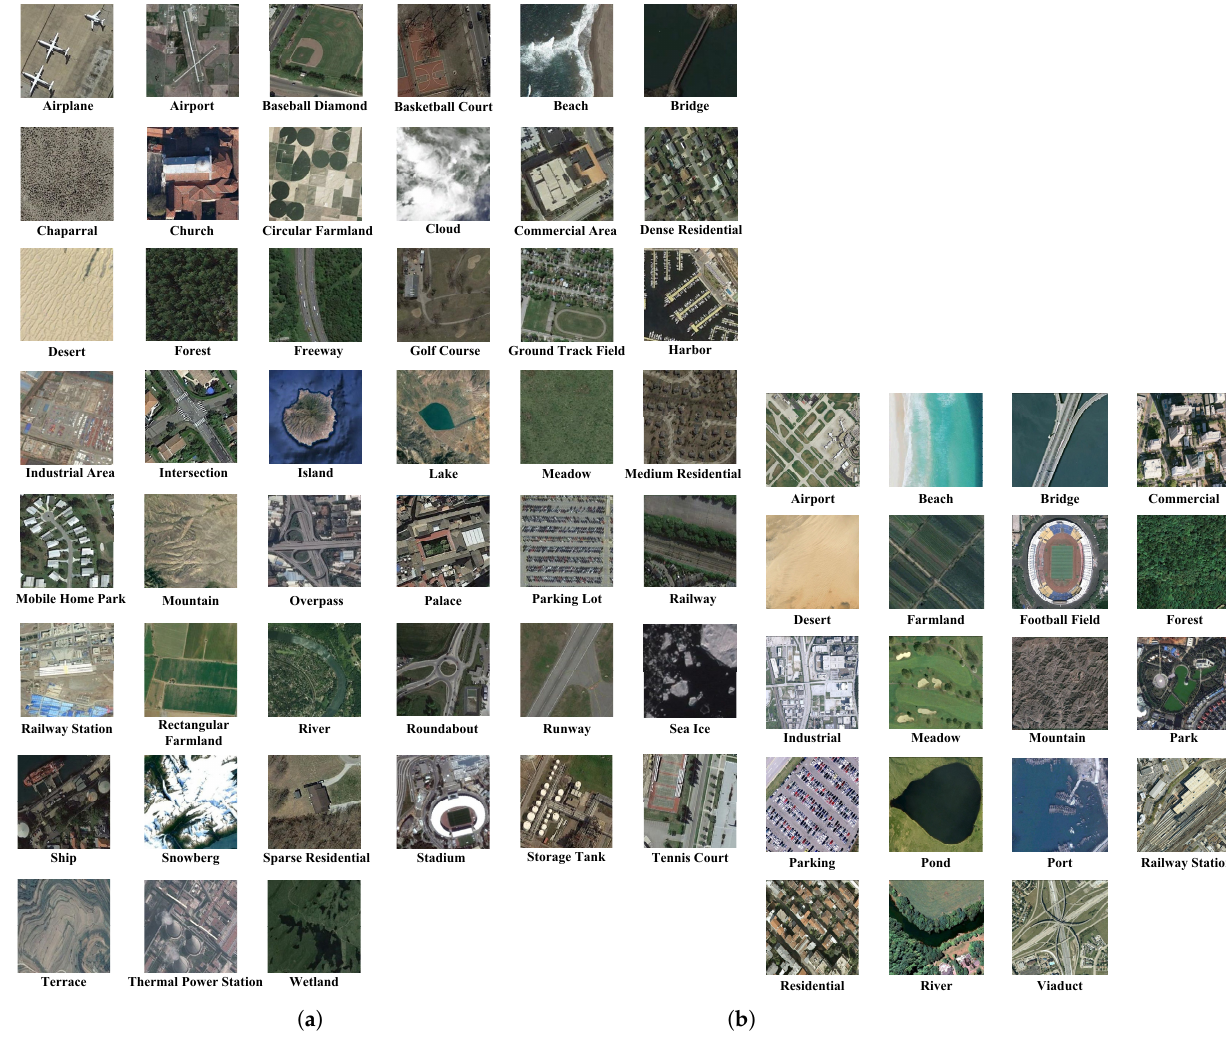
Figure 4. Datasets utilized in the experiments, ( a ) images of NWPU-RESISC45 dataset, ( b ) images of WHU-RS19